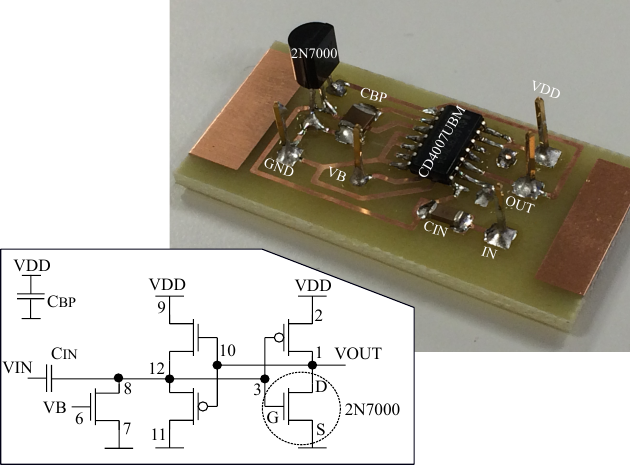
Figure 22. LL-PFGA prototype, implemented with 2N7000 and